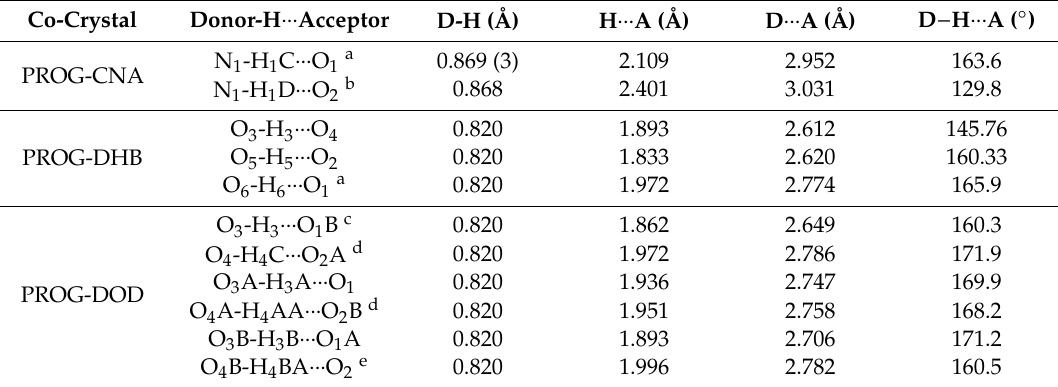
Table 3. Hydrogen bonds and angles in PROG-CNA, PROG-DHB, and PROG-DOD.